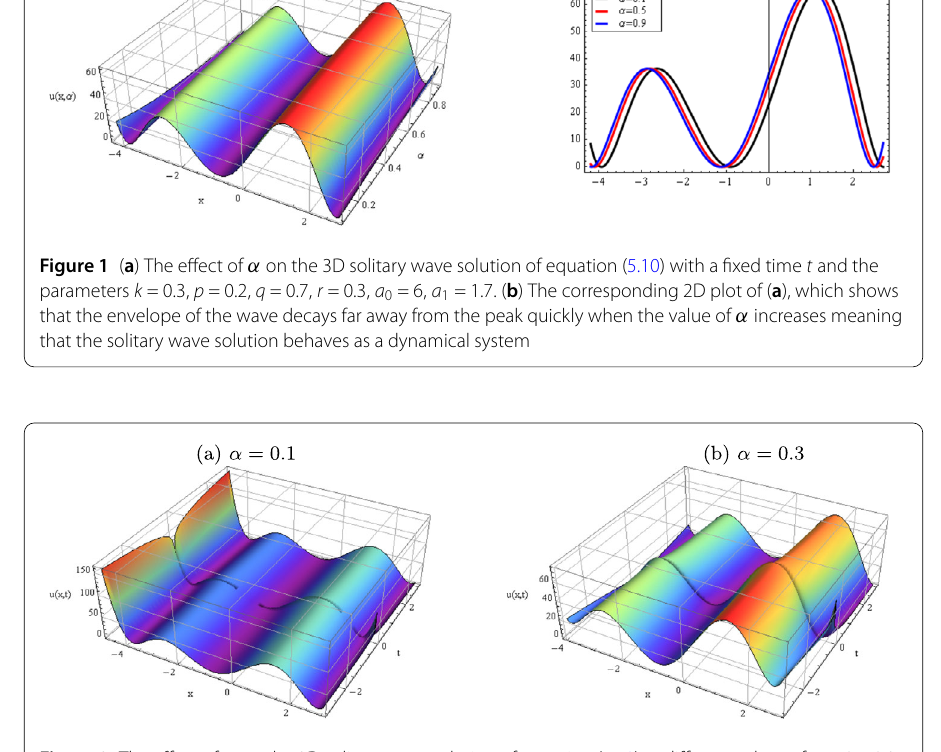
Figure 2 The effect of α on the 3D solitary wave solution of equation (5.10) at different values of α = 0.1,0.3 with the suitable parameters k = 0.3, p = 0.2, q = 0.7, r = 0.3, a 0 = 6, a 1 = 1.7